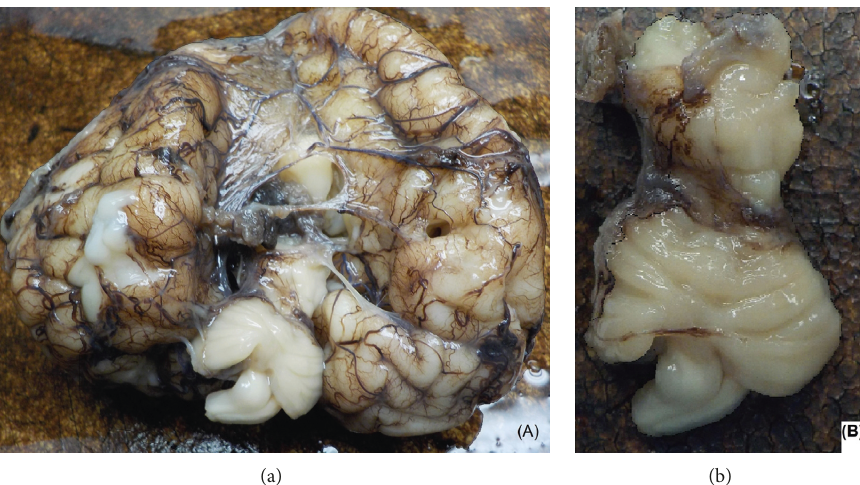
Figure 2: (a) Normal for gestational age cerebrum with markedly diminished cerebellar volume. (b) Marked hypoplastic cerebellum with rudimentary vermis.